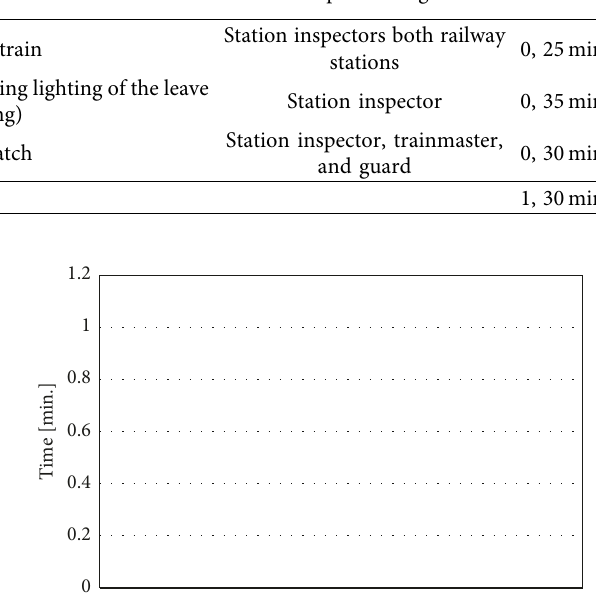
Figure 10: The resulting comparison of the crossing interval ( τ